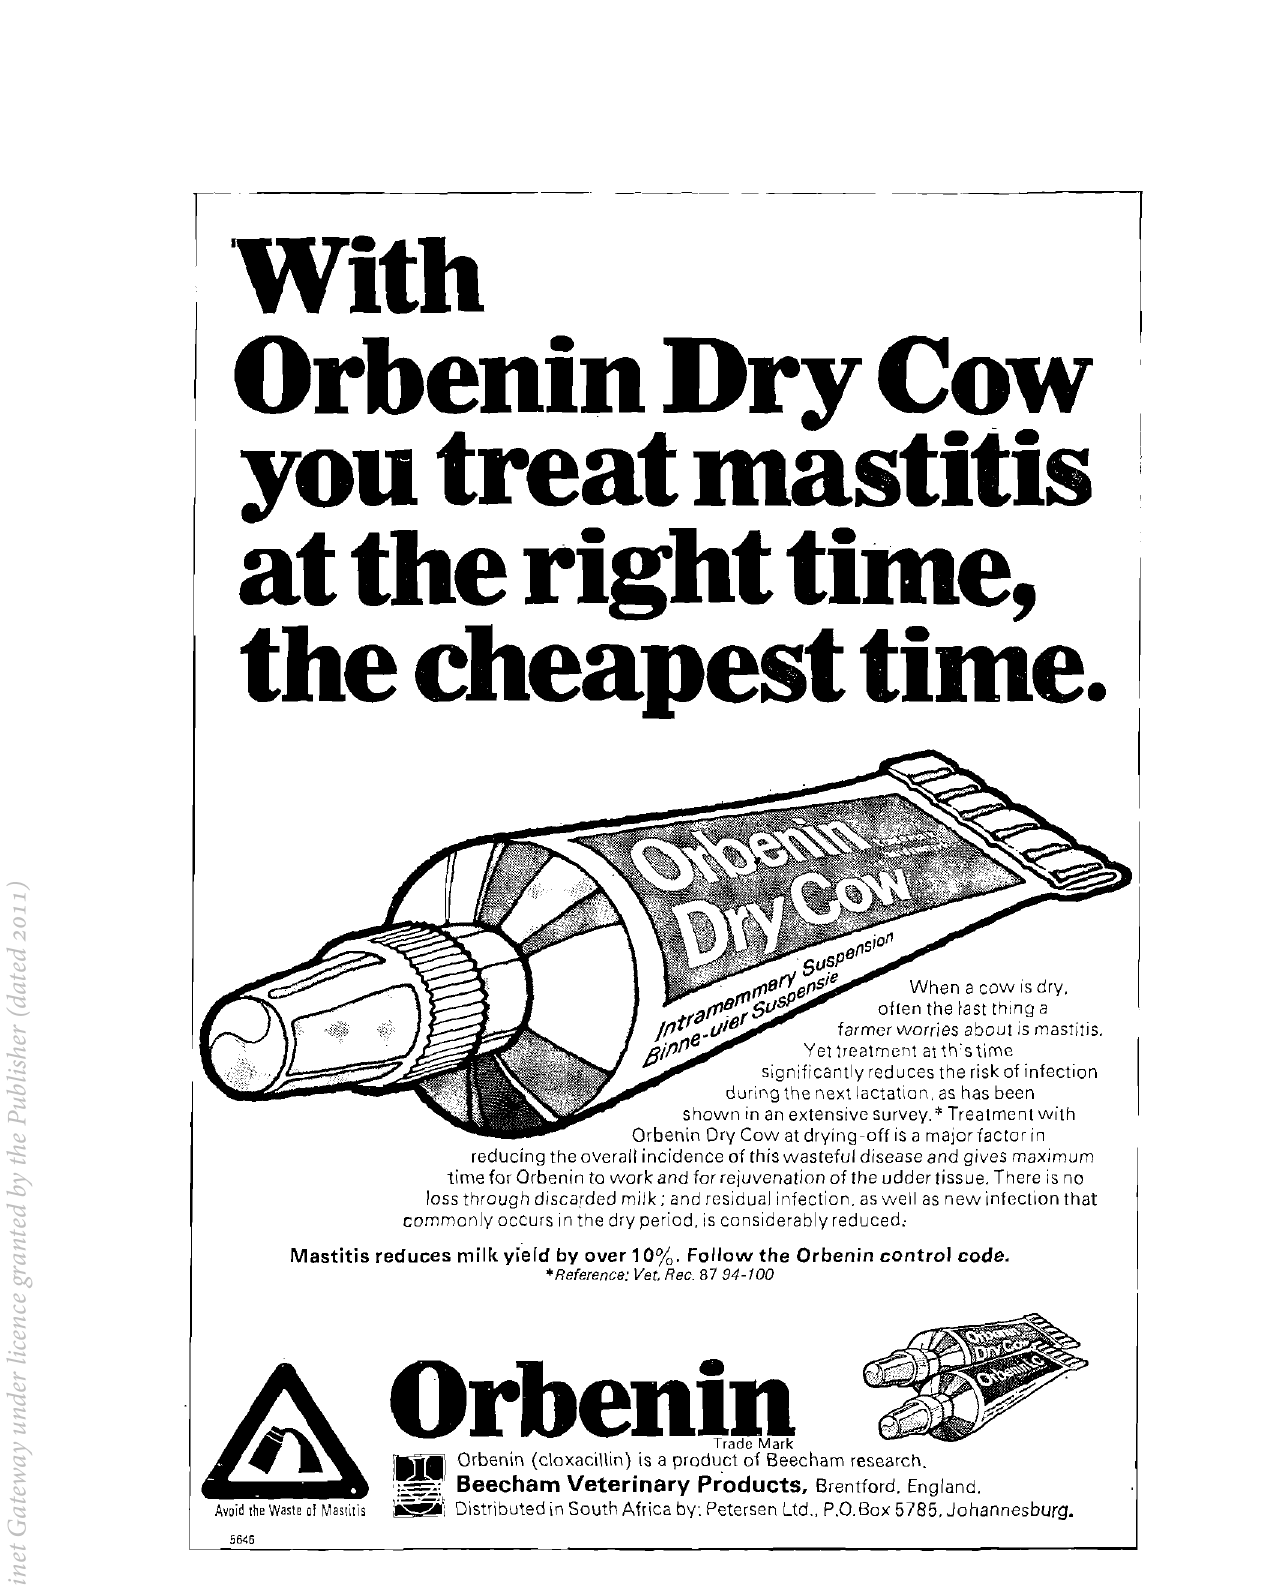
When a cow is dry, often the fast thing a farmer worries about is mastitis. Yettreatment a1th's time significantly reduces the risk of infection during the next lactation. as has been shown in an extensive survey. * Treatment with Orbenin Ory Cow at drying-off is a majorfactorin reducing the overall incidence of this wasteful disease and gives maximum time for Orbenin to work and for rejuvenation of the udder tissue. There is no loss through discarded milk; and residual infection, as well as new infection that commonly occurs in the dry period, is considerably reduced, Mastitis reduces milk yield by over 1 0%. Follow the Orbenin control code. OReference; Vet. Rec. 87